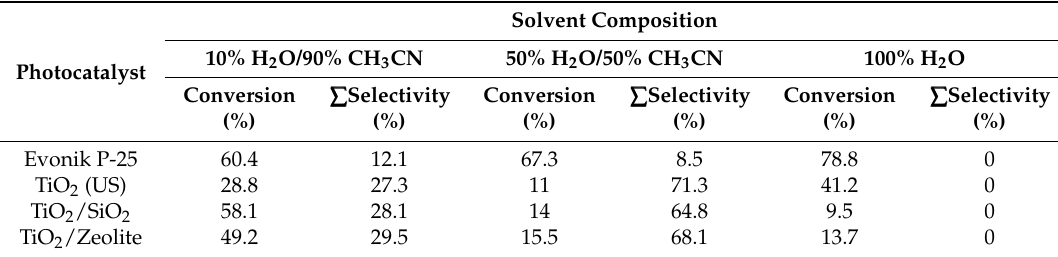
Table 2. Effects of solvent composition on glucose conversion and selectivity towards glucaric/gluconic acids using TiO 2 (US), Evonik P-25, TiO 2 /SiO 2 , and TiO 2 /Zeolite after 10 min of light irradiation from Colmenares et al.